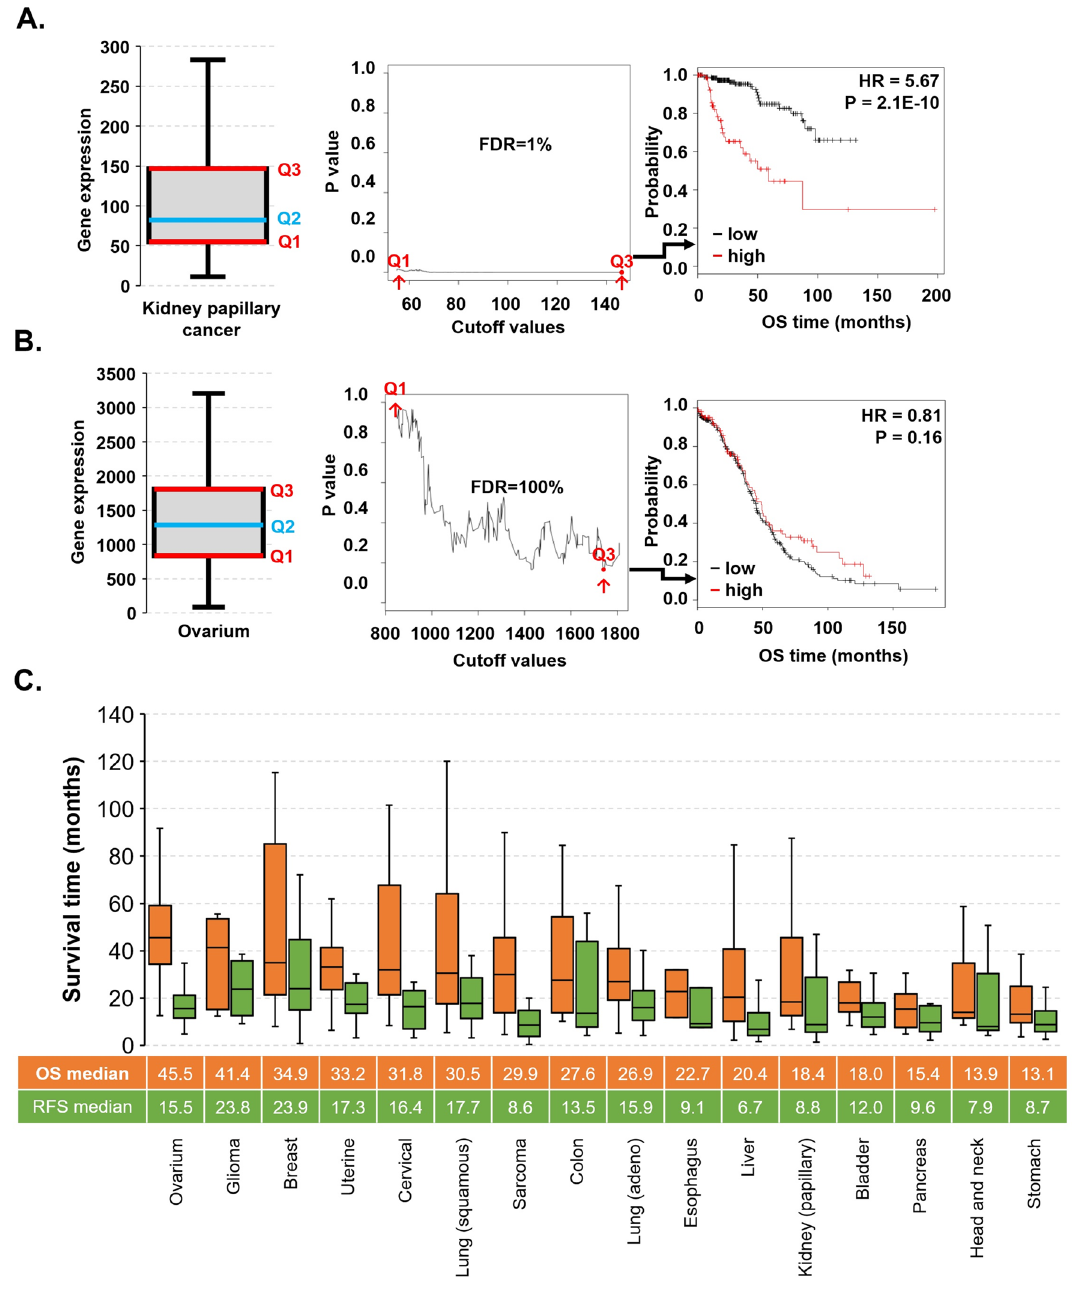
Figure 1. Overview of cutoff determination and survival distribution in the database. The determination of the best cutoff value in the survival analysis demonstrated with the CDK1 gene in kidney papillary carcinoma ( A ) and ovarian cancer ( B ). Survival time characteristics of tumors with observed events ( C